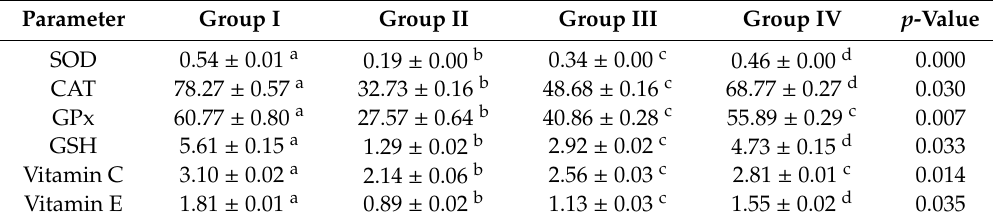
Table 5. E ff ect of EEAB on enzymatic and non-enzymatic antioxidants in liver of rats intoxicated with CCl 4 . Parameter